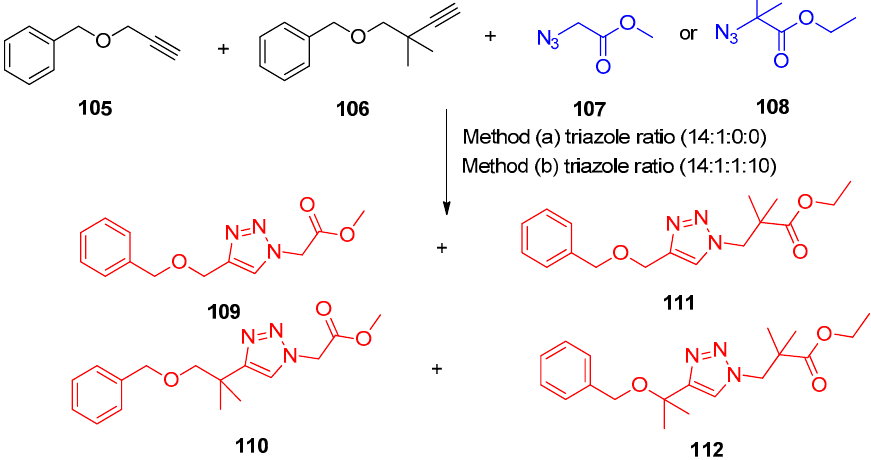
Scheme 51. Synthesis of triazoles 109 – 112 . Reagents and conditions: Method (a) 1-TFPB (15